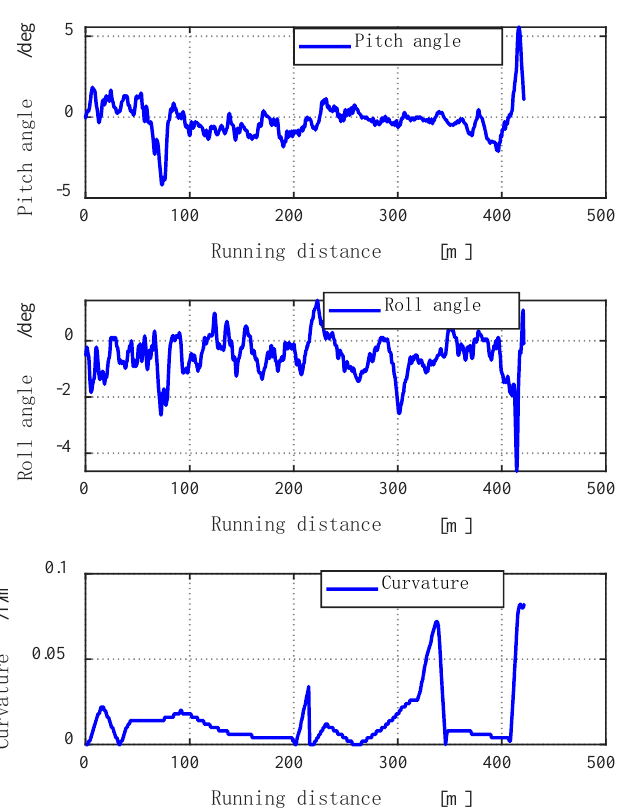
Figure 12. Vehicle pitch angle and roll angle and route curvature.